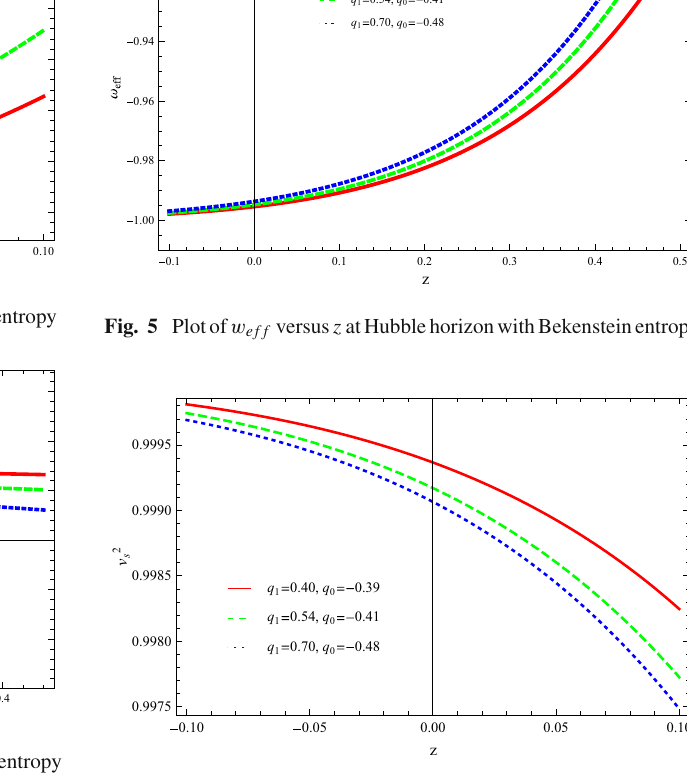
thermal equilibrium condition satisfies at early, present as well as later